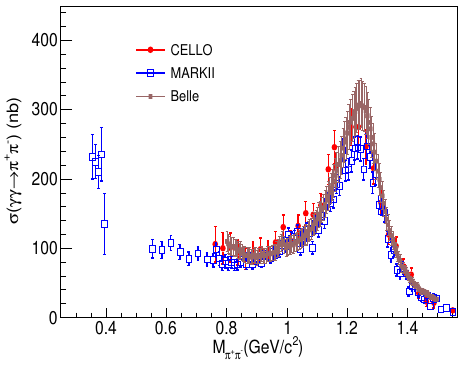
Figure 7: The cross section of γγ → π + π − as a function of the invariant mass of π + π − from the MarkII [ 30 ] , CELLO [ 31 ] , and Belle [ 32 ]